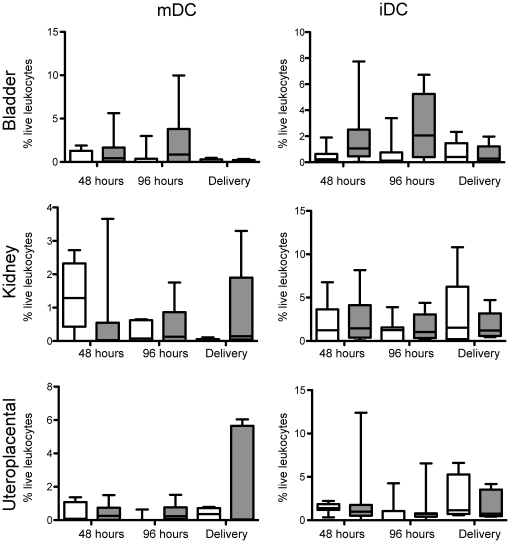
Presence of dendritic cells in uteroplacental tissues.The magnitude of the particular cell type of interest is reported as a percentage of live leukocytes within each individual organ indicated from pregnant mice that received sham infection (white) or experimental UTI (gray) at 48 h (10 mice each cohort), 96 h (10 mice each cohort), and delivery (8 mice each cohort. Statistical significance determined using a two-tailed Mann Whitney for internal comparisons within each time point, no significance observed. Abbreviations: mDC, mature dentritic cell; iDC, immature dendritic cell.